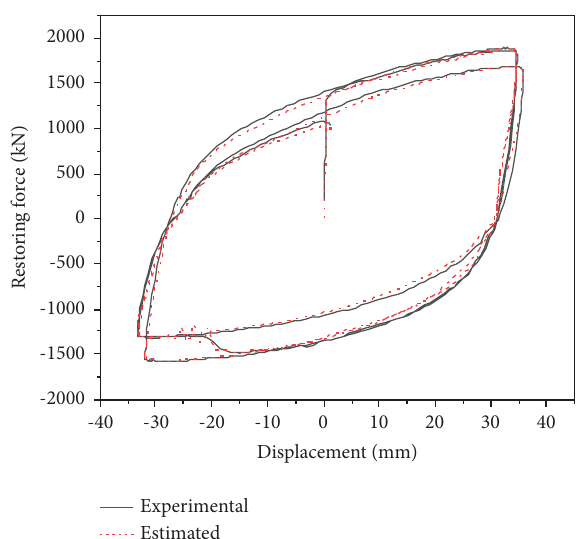
Figure 8: Hysteresis cycles for large range sampling